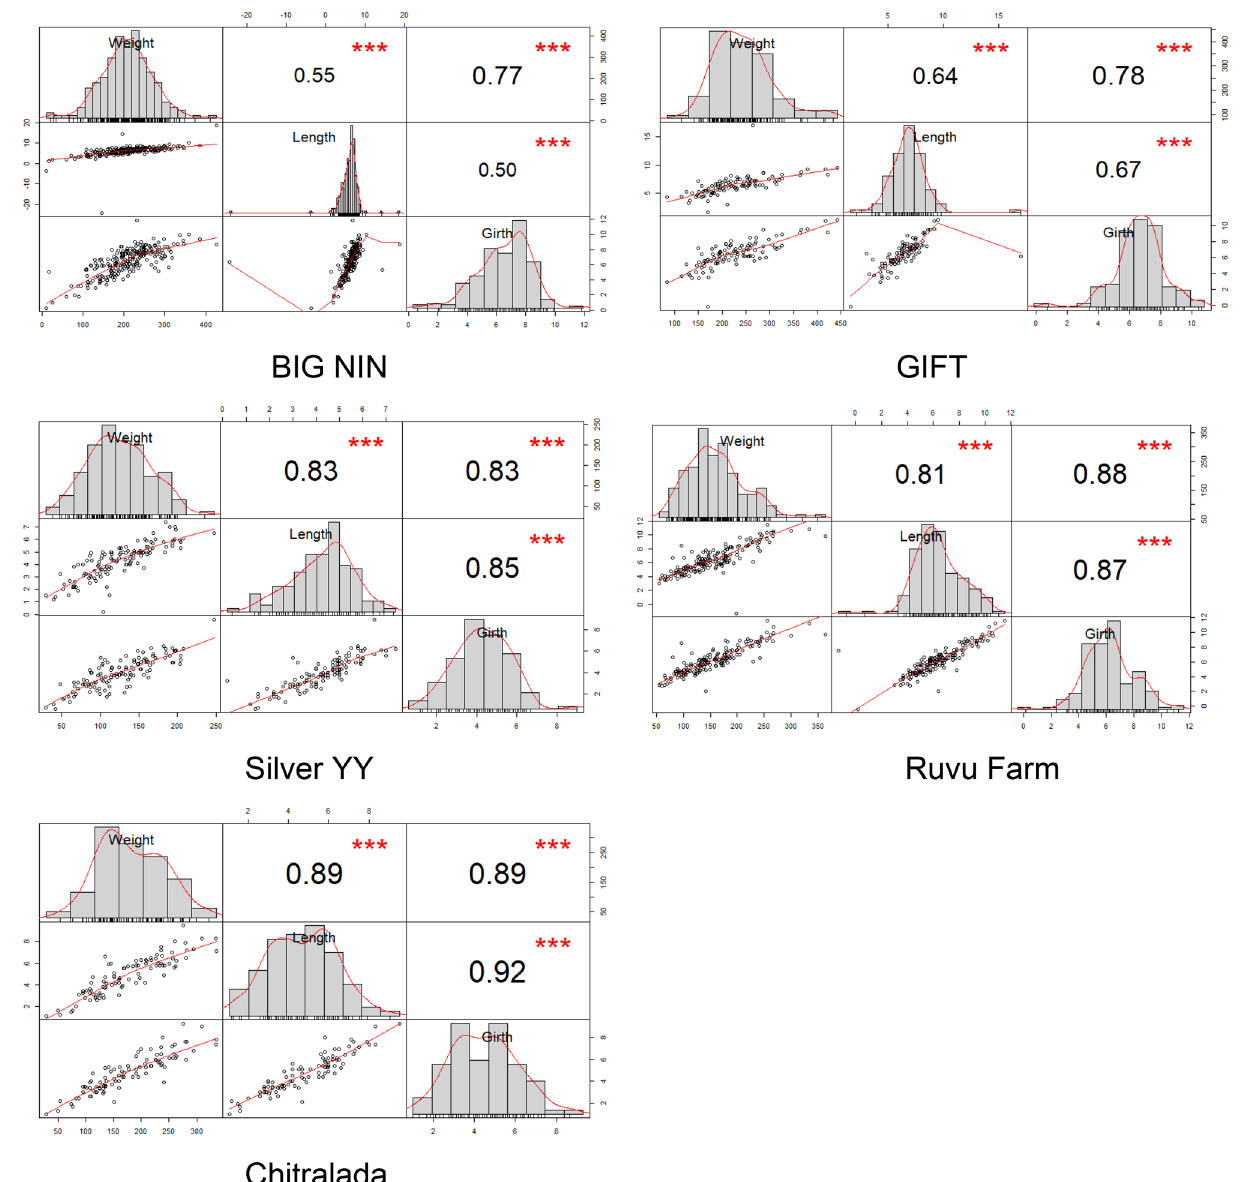
Figure 2. Correlation coefficient representing gained body weight, standard length and girth of Nile tilapia strains reared at Kunduchi and